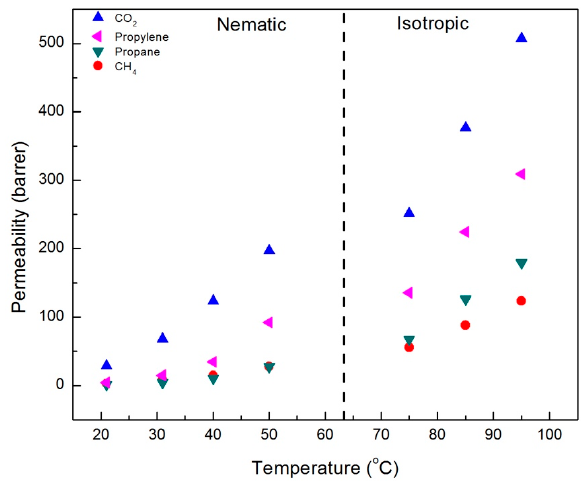
Figure 6. Single gas permeabilities for the CNBPh75_5.0 membrane (5.0% crosslinker) plotted as a function of temperature in the nematic and isotropic phases.